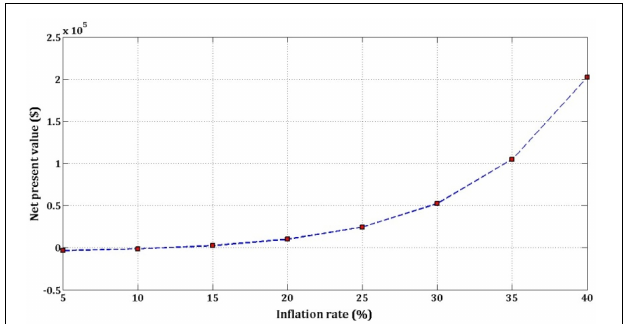
TABLE 8 | Results of economic analysis based on method 2.